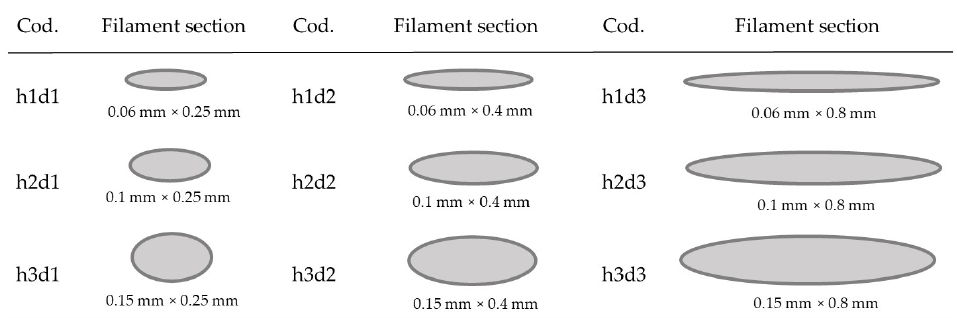
Figure 3. Theoretical elliptical sections of filaments.